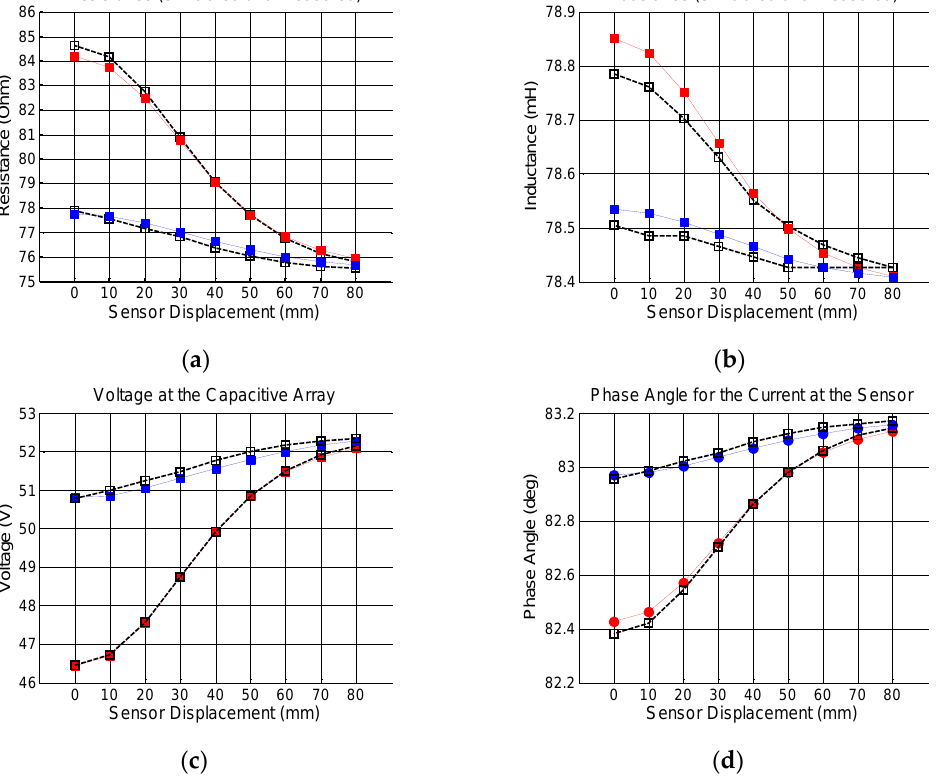
Figure 7. Simulated (color marks) and experimental results (hollow black marks) for the effective resistance ( a ), effective inductance ( b ), voltage ( c ) and phase angle ( d ) for a 20 mm steel bar. Red marks: Steel bar placed 25 mm under the sensor. Blue marks: Steel bar placed 45 mm under the sensor.